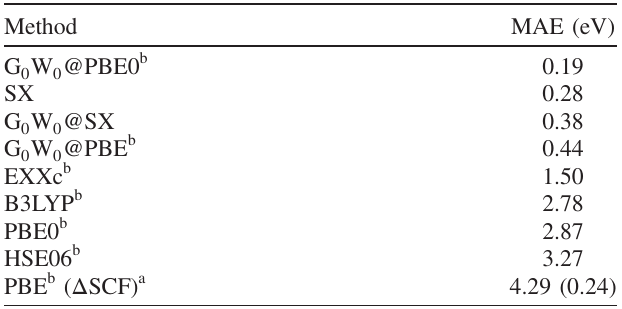
TABLE I. MAE in the vertical ionization potential of 36 closed- shell molecules predicted by the highest occupied molecular orbital energy computed using the SX functional (SX) (see text), G 0 W 0 starting from PBE0 wave functions (G 0 W 0 @ PBE 0 ), the SX hybrid functional (G 0 W 0 @ SX), and PBE (G 0 W 0 @ PBE). We also show the results for Hartree-Fock exchange with PBE correlation (EXXc), B3LYP [72], PBE0 [21], and HSE06 [22] for